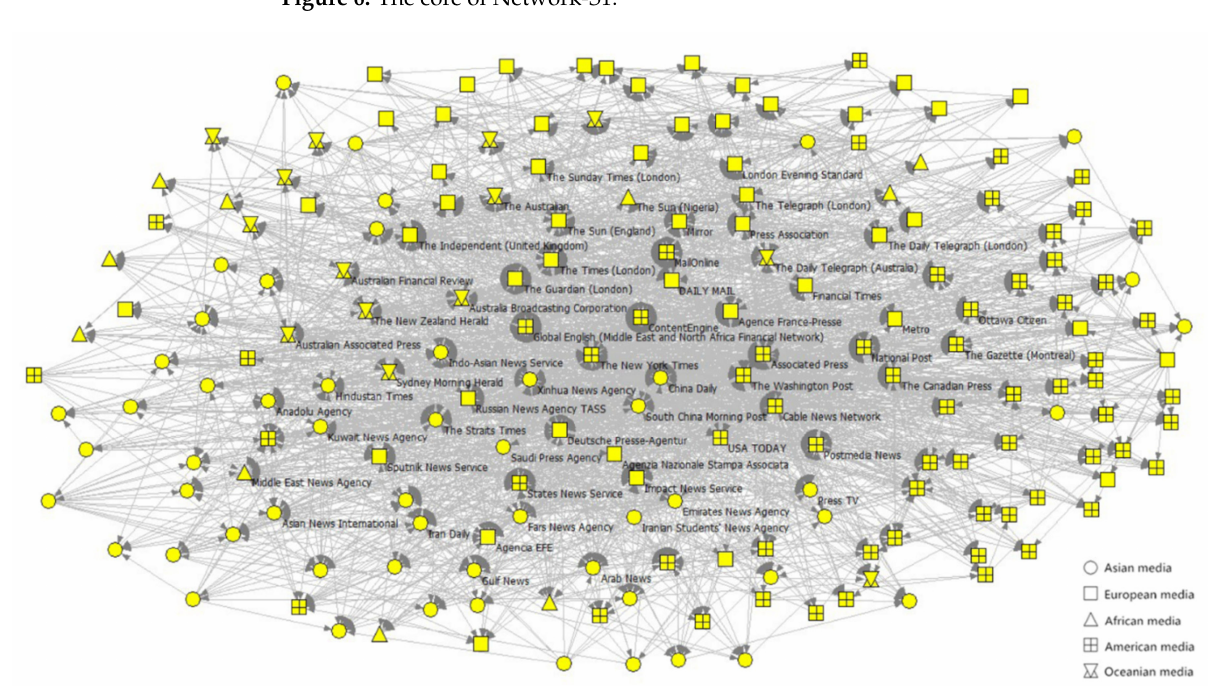
Figure 7. The core of